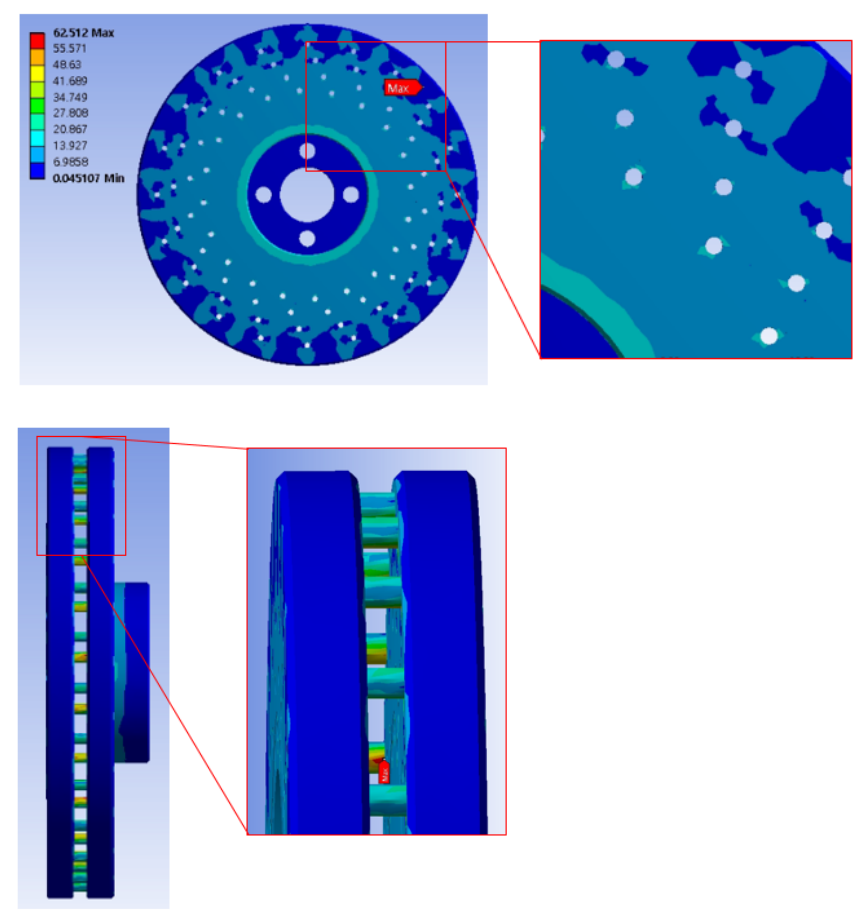
Figure 6. Von Mises stress distribution.